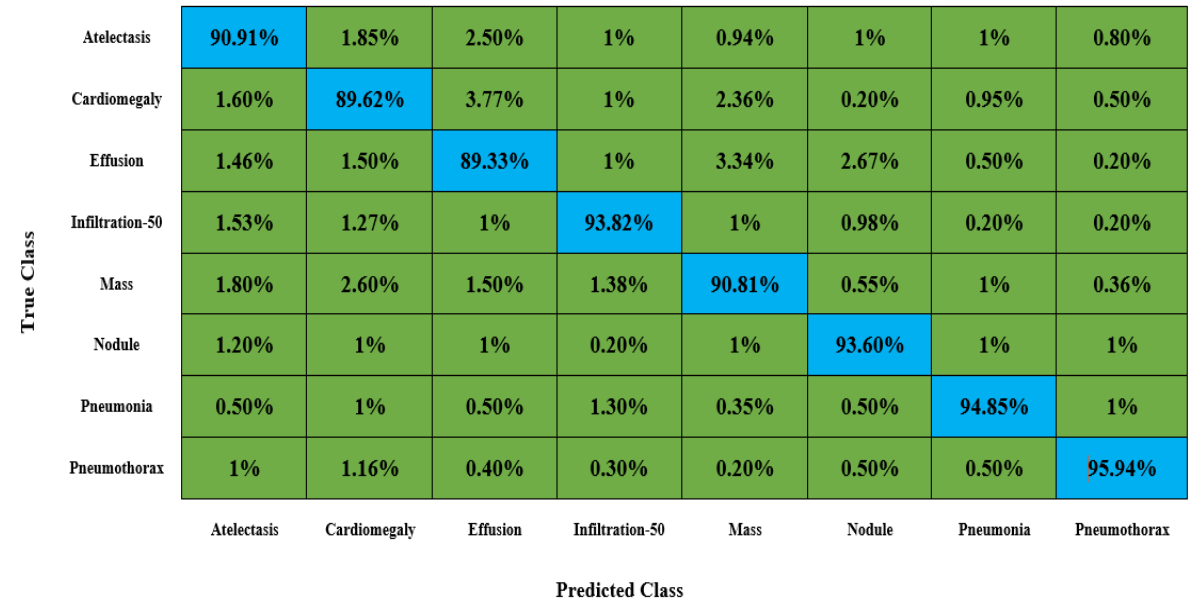
Figure 11. Attained confusion matrix results for the CXray-EffDet model.